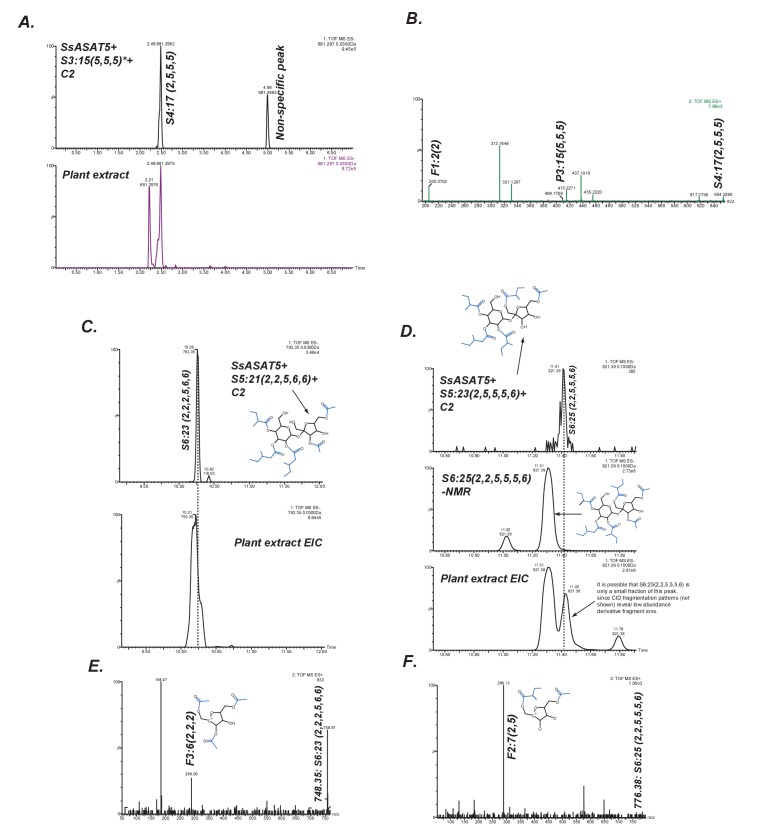
SsASAT5 putative secondary activities.(A) SsASAT5 can transfer C2 to S3:15 (5,5,5) isolated from Solanum pennellii-derived Backcross Inbred Line BIL6180 (unpublished data; Ofner et al., 2016), which has the three acyl chains on the R2, R3 and R4 pyranose (abbr: P) ring, same as Salpiglossis. (B) The C2 addition likely occurs on the furanose (abbr: F) ring, as seen by the presence of the m/z 205.07 in the positive-ion mode elevated collision energy mass spectrum. (C,D) SsASAT5 can transfer C2 to penta-acylated sucroses, and the product co-migrates with an acylsugar of the same molecular mass produced in the plant. Co-migrating peaks are aligned by the dashed line. Central panel in (D) shows that the S6 sugar produced by SsASAT5 is not the same as the most abundant acylsugar produced by the plant purified for NMR, which has two C2s on the furanose ring. Shown are extracted ion LC/MS chromatograms for the expected masses. (E,F) The most abundant fragment ions (m/z: 289.09, 289.13) are consistent with C2 addition occurring on the furanose and pyranose rings, respectively.